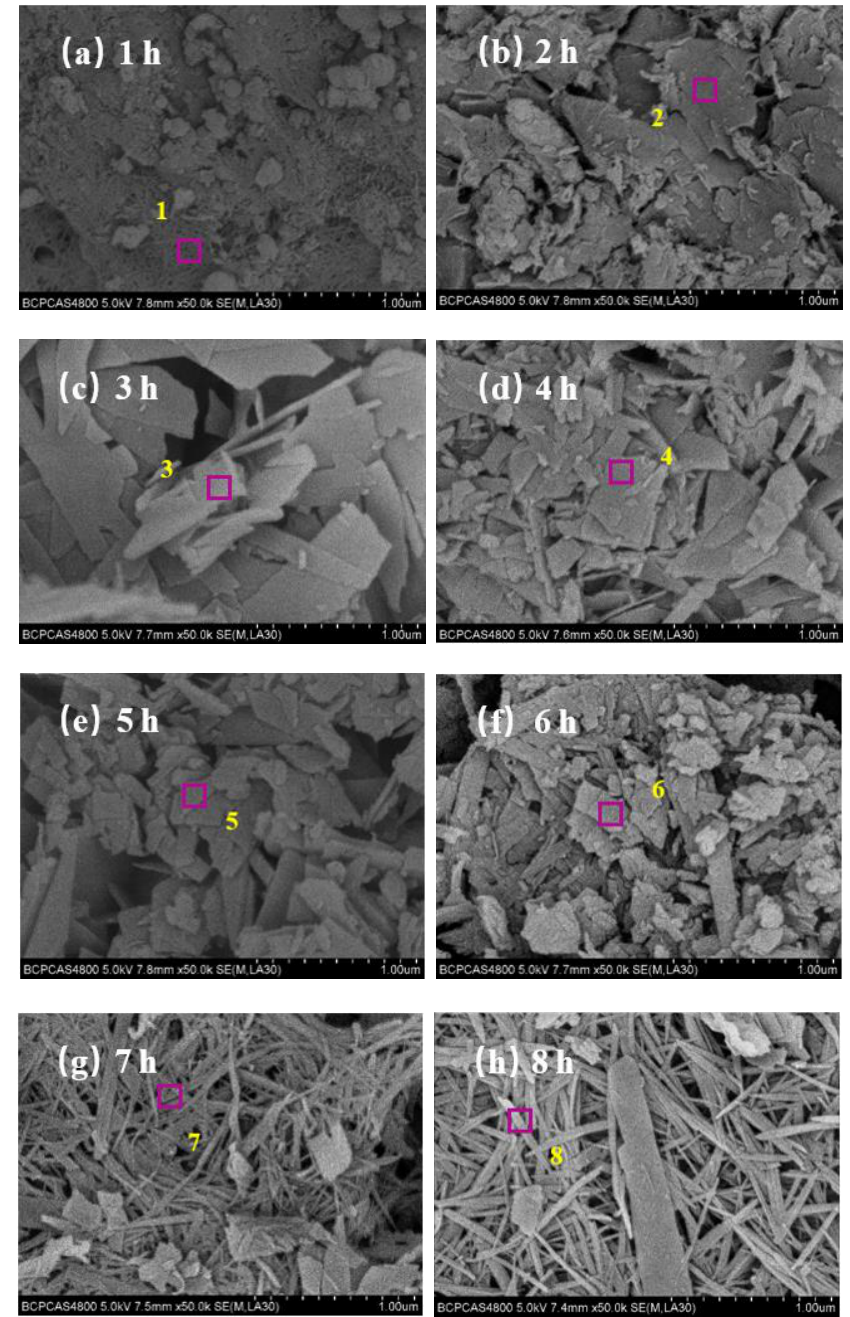
Figure 2. SEM images of hydrothermal synthesis at different hydrothermal synthesis times. ( a ) 1 h, ( b ) 2 h, ( c ) 3 h, ( d ) 4 h, ( e ) 5 h, ( f ) 6 h, ( g ) 7 h, ( h ) 8 h. The pink squares in the figure represent EDS region, while yellow numbers indicate EDS region serial number.